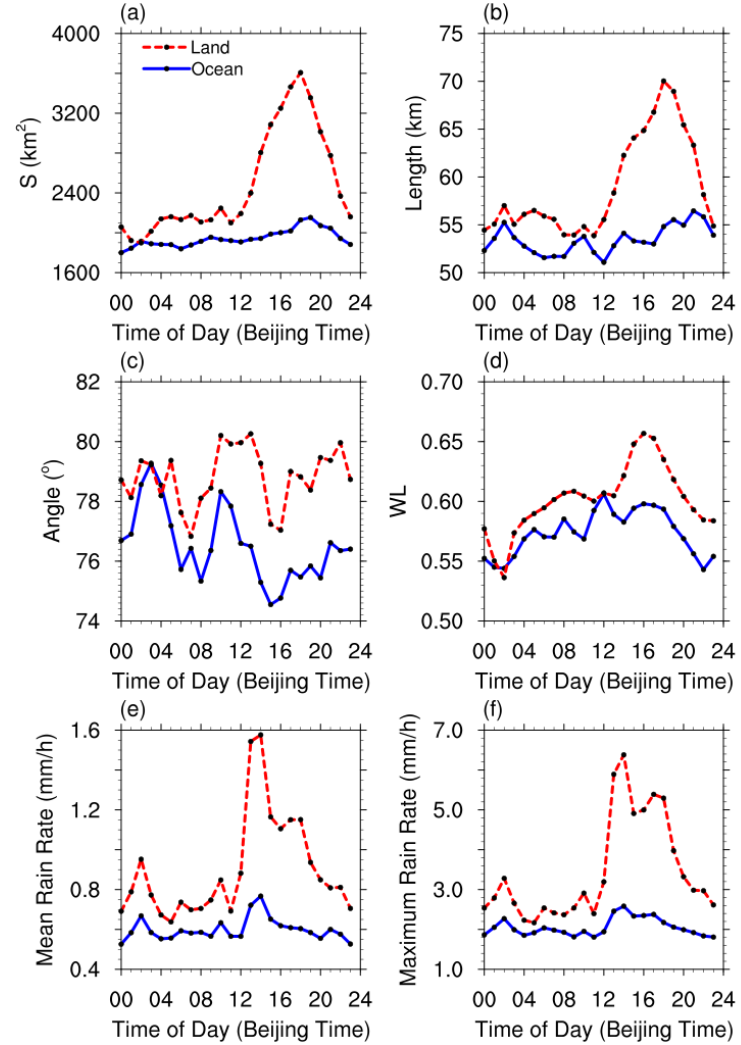
Figure 6. Diurnal variation of the parameters of oceanic and continental rain clusters: ( a ) S , ( b ) length, ( c ) rotation angle, ( d ) WL , ( e ) mean rain rate and ( f ) maximum rain rate. The red dotted and blue solid lines represent continental and oceanic rain clusters, respectively (Beijing Time, UTC+8).